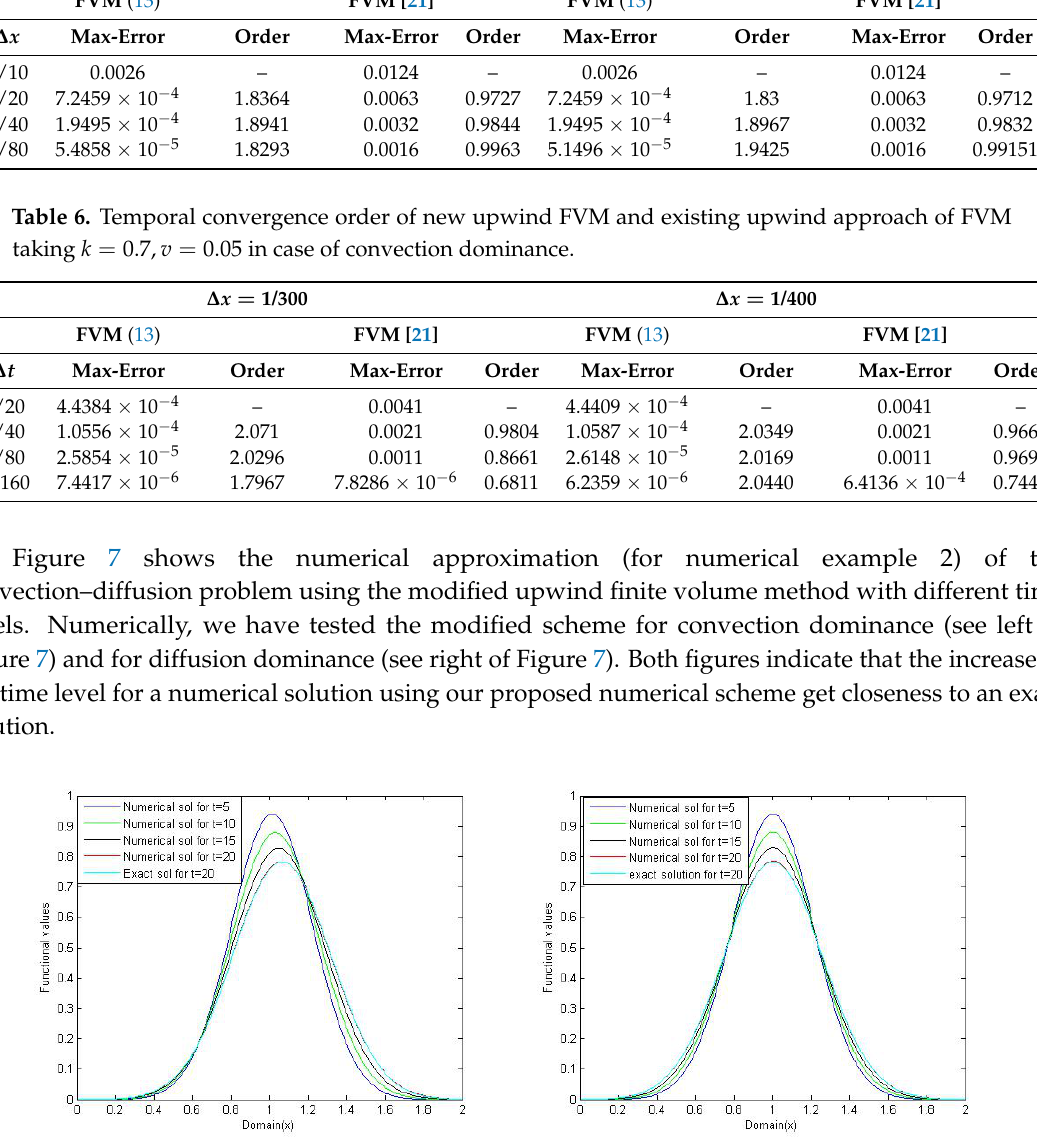
Figure 7. Numerical approximation for convection dominance (at ( left ) with k = 0.08, v = 0.4) and diffusion dominance (at ( right ) with k = 0.08, v = 0.01) taking ∆ x = 2/220 for numerical example